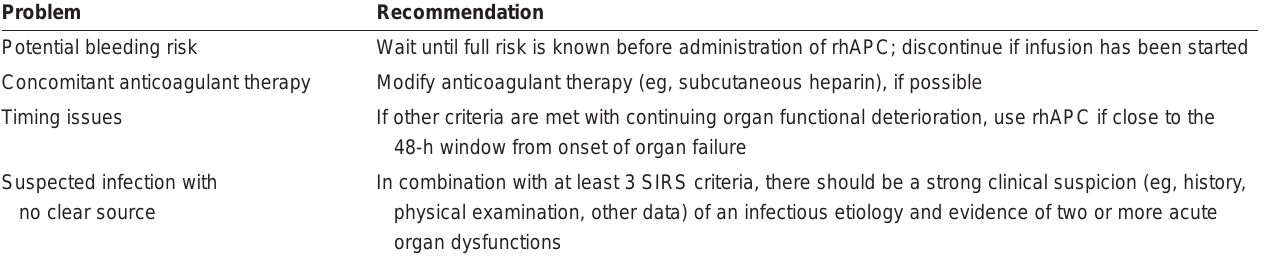
TABLE 10 Common concerns about treatment with recombinant human activated protein C (rhAPC)